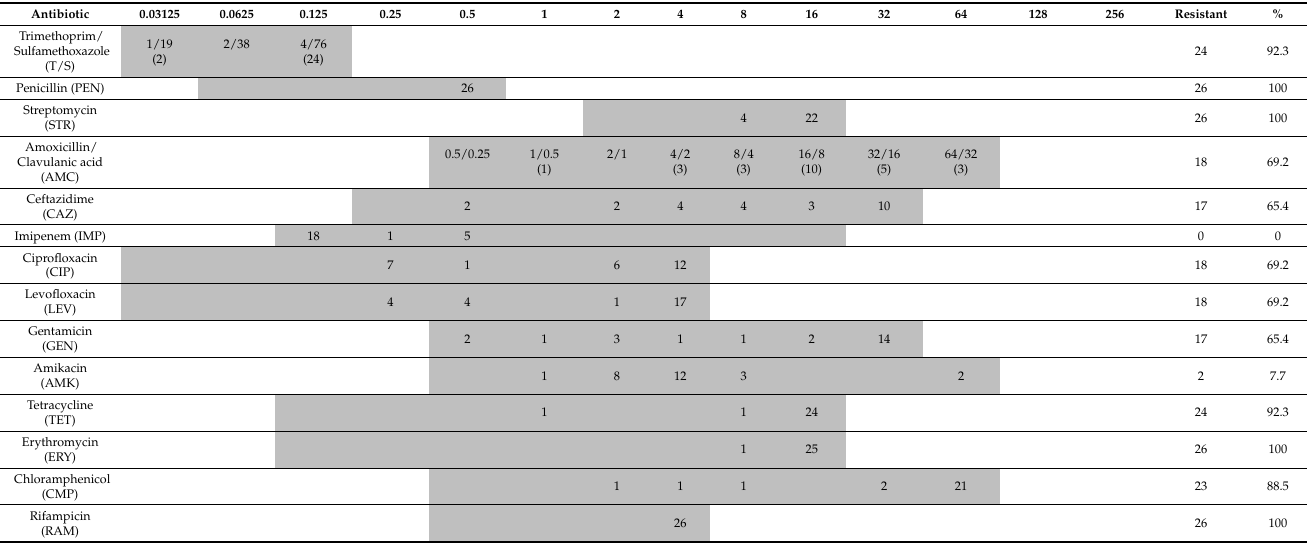
Table 3. Phenotypic resistance profiles of E. coli isolates detected by broth